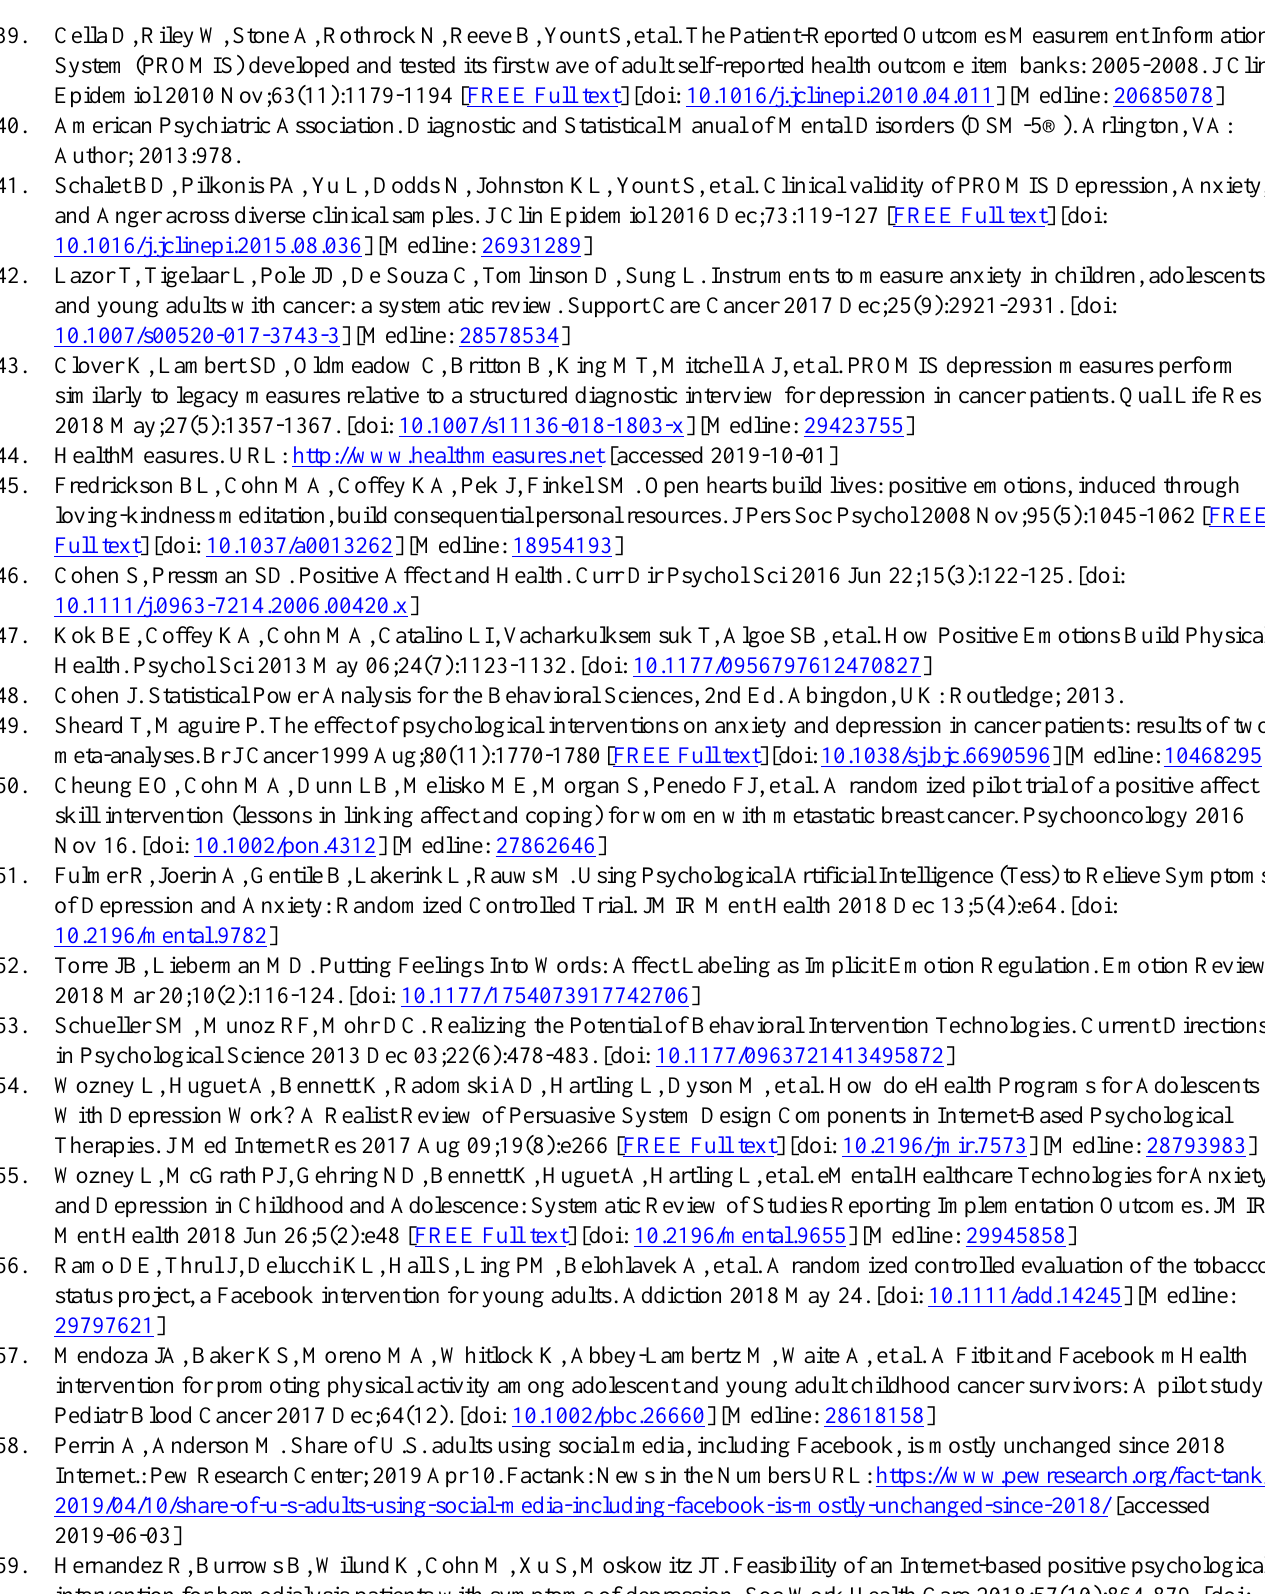
PRISM: Promoting Resilience in Stress Management PROMIS: Patient-Reported Outcomes Measurement Information